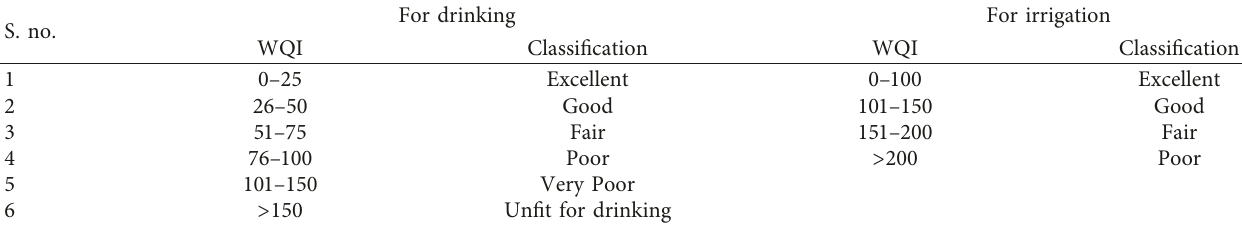
Table 2: Horton’s WQI.